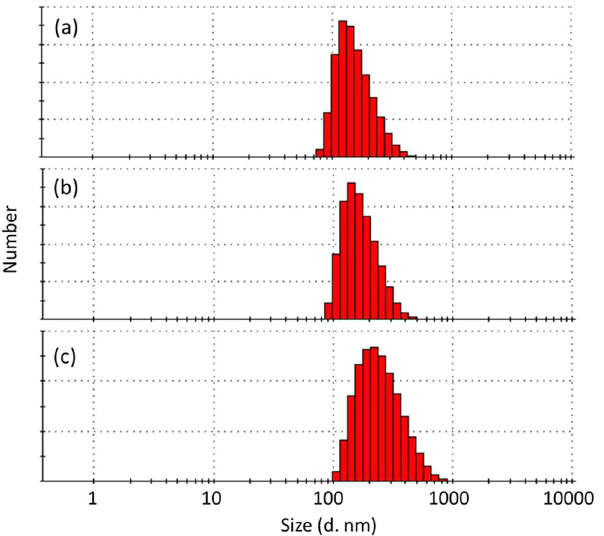
Figure 2. Hydrodynamic diameter distribution of the MNPs determined by DLS measurements: ( a ) streptavidin coated MNPs ( b ) ssDNA conjugated MNPs, and ( c ) anti-PSMA antibody conjugated MNPs.